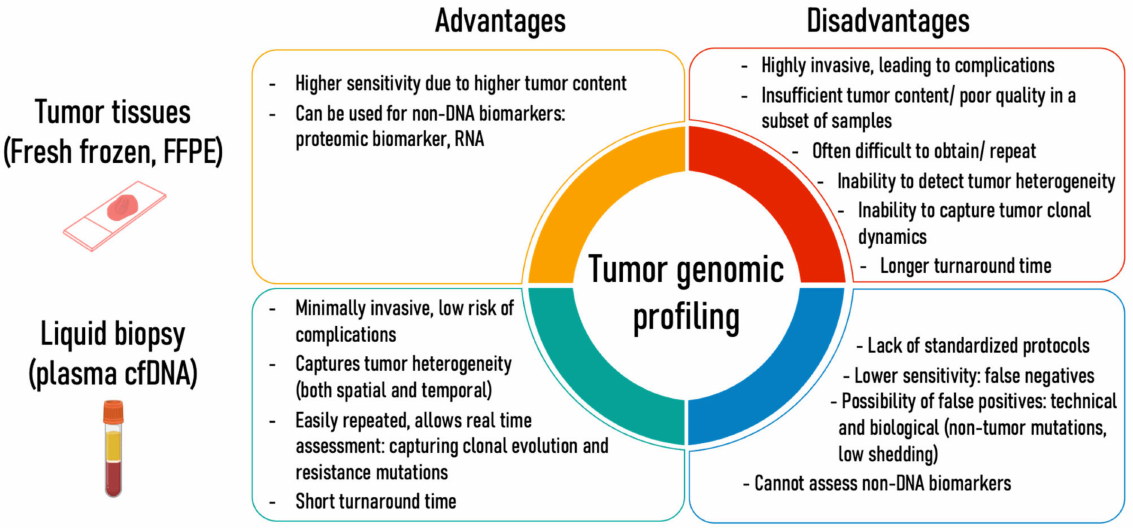
Figure 1. Advantages and disadvantages of tumor genomic profiling using tumor tissues and plasma